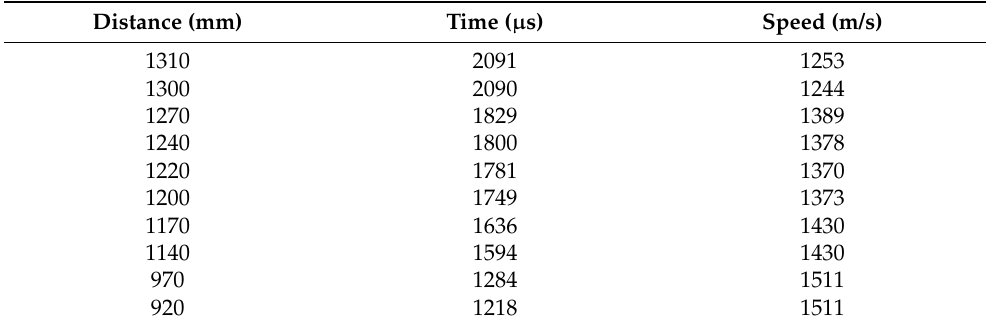
Table 2. Test data of 10 kHz ultrasonic transducer on the longitudinal-transducer calibration platform. Distance (mm) Time ( µ